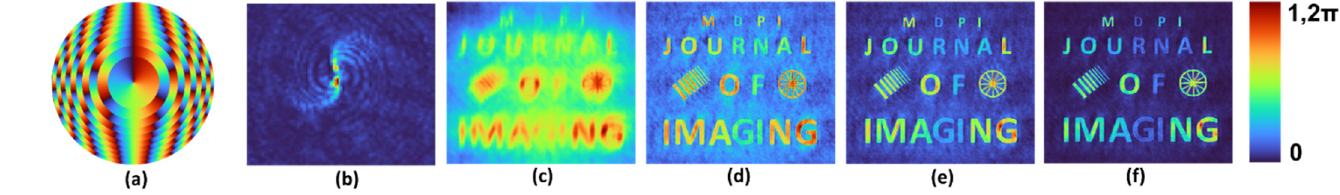
Figure 16. ( a ) Phase image of the multifunctional DOE. ( b ) Recorded PSF, ( c ) object’s response pattern. Reconstruction results using ( d ) NLR ( p = 1), ( e ) NLR ( p = 2) and ( f ) NLR ( p = 3) for double-helix beam with rotating PSF.